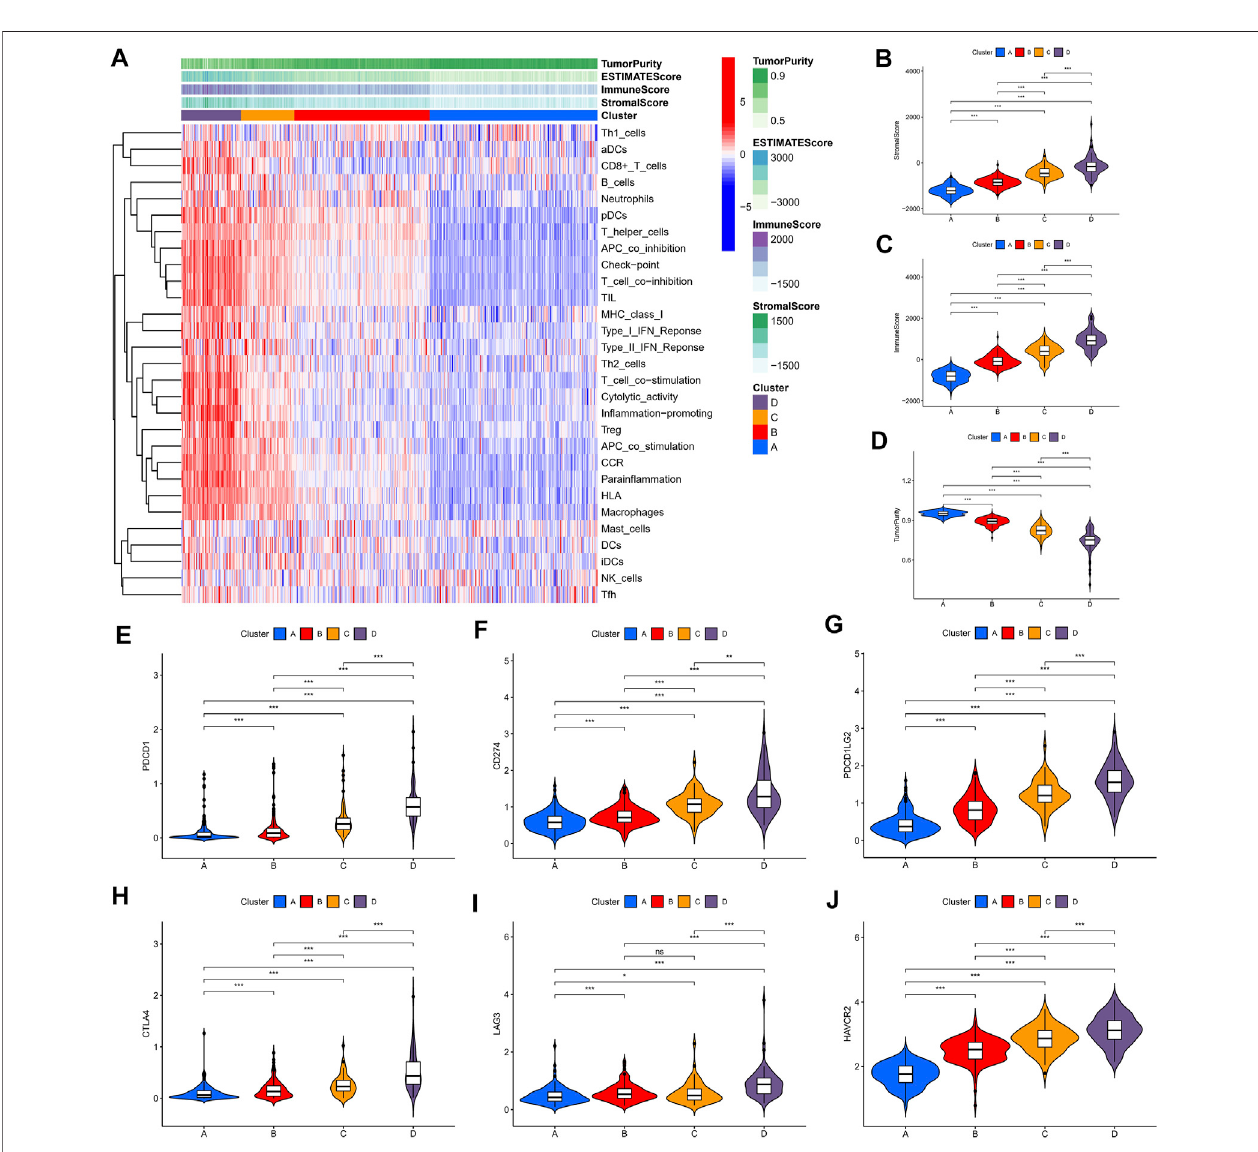
FIGURE 2 | Immune characteristics of the four clusters in the TCGA dataset. (A) Heat map of the four immune clusters based on ssGSEA scores. (B) Stromal scores, (C) immune scores, and (D) tumor purity of different clusters. (E – J) Violin plots for the immune checkpoint gene expressions of PDCD1, CD274, PDCD1LG2, CTLA-4, LAG3, and HAVCR2 in different